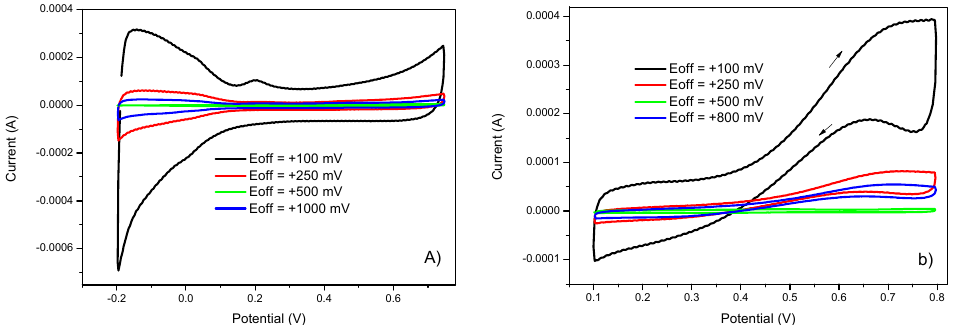
Figure 4. Cyclic voltammetry in ( a ) 0.5 M H 2 SO 4 and in ( b ) 2 M methanol + 0.5 M H 2 SO 4 of GC/PANI(CV)/PtNPs electrodes obtained at various upper potentials (E off ) = +100, +250, +500, and +800 mV.